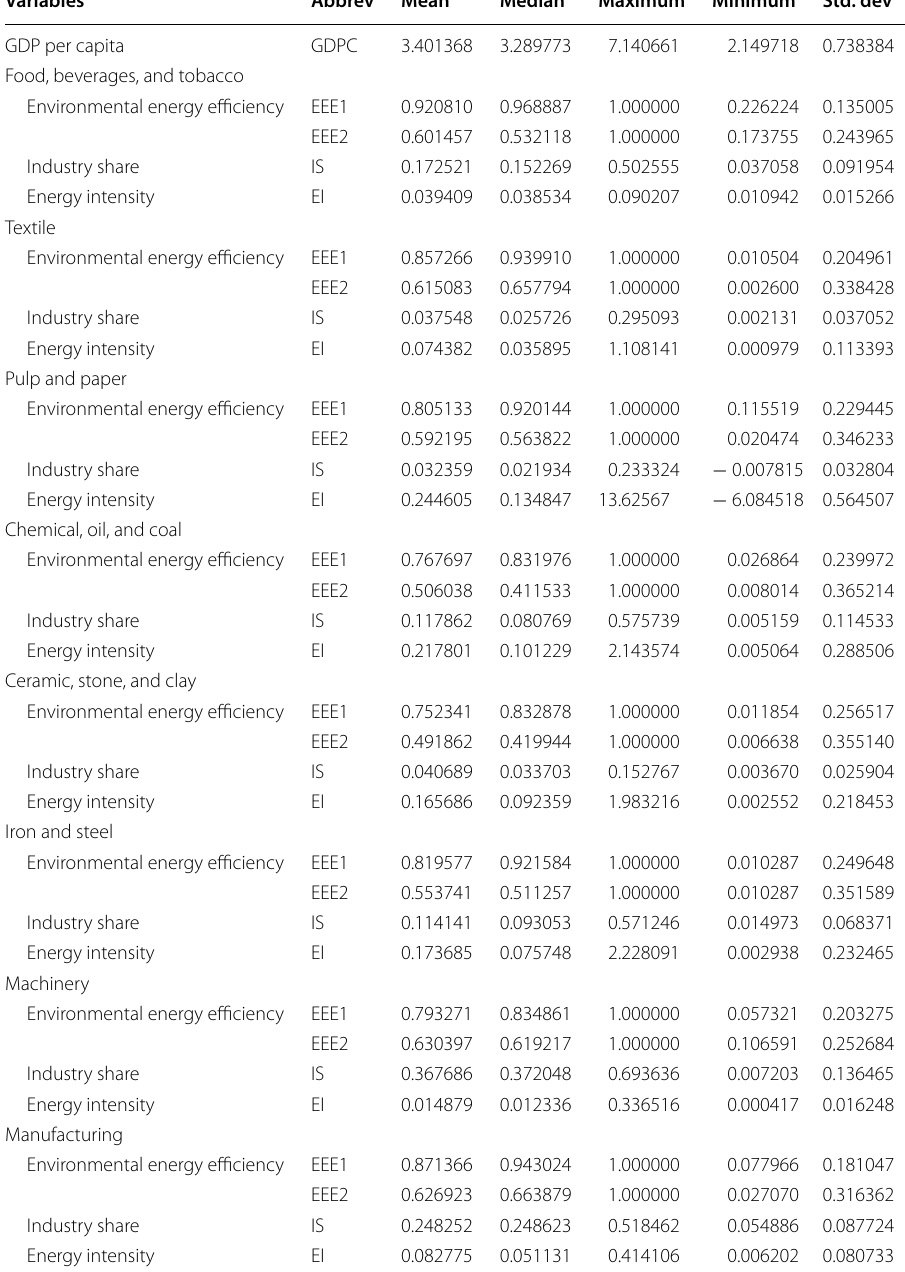
Table 3 Descriptive statistics of